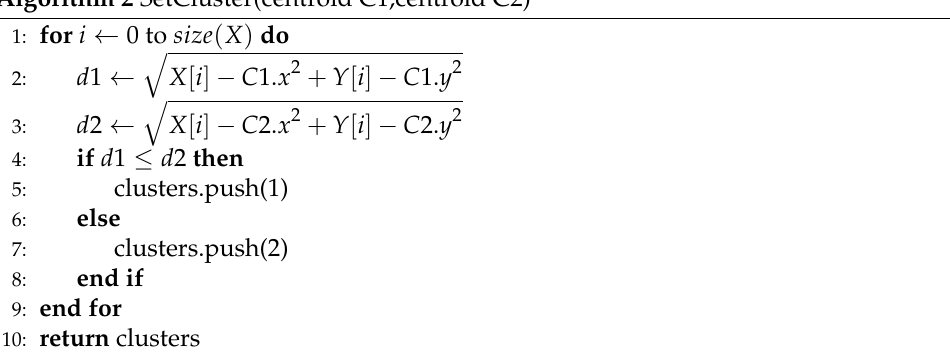
Algorithm 2 SetCluster(centroid C1,centroid